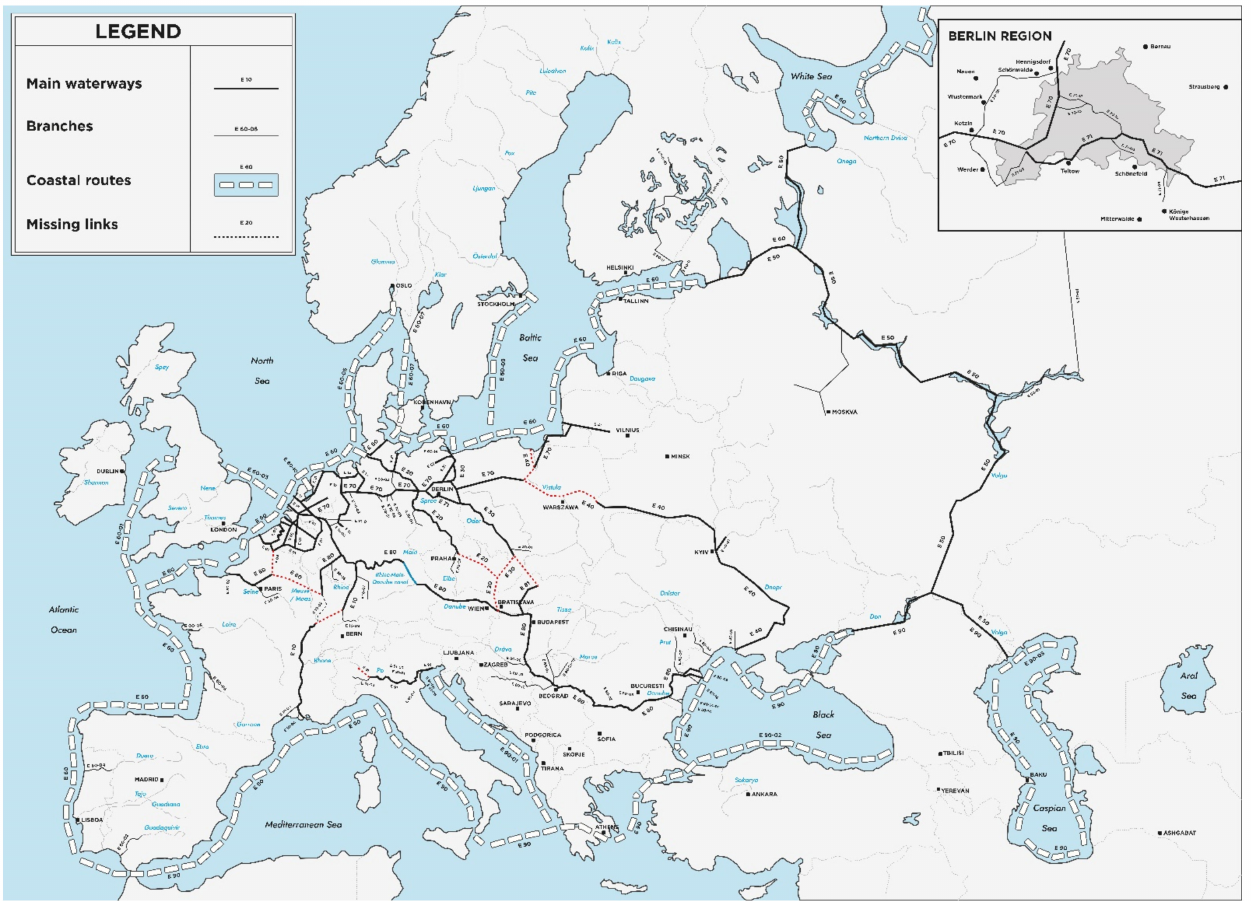
Figure 1. Map of the potential pan-European inland waterway network showing how the E40